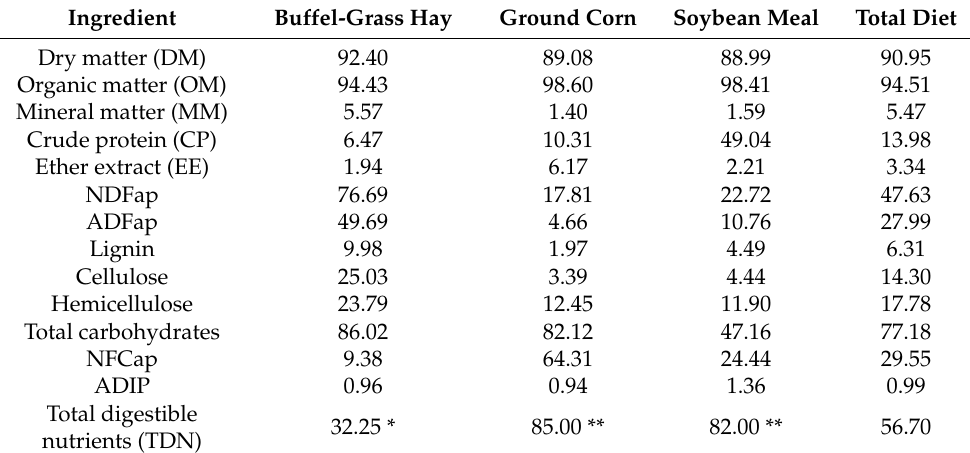
Table 1. Chemical composition of the experimental